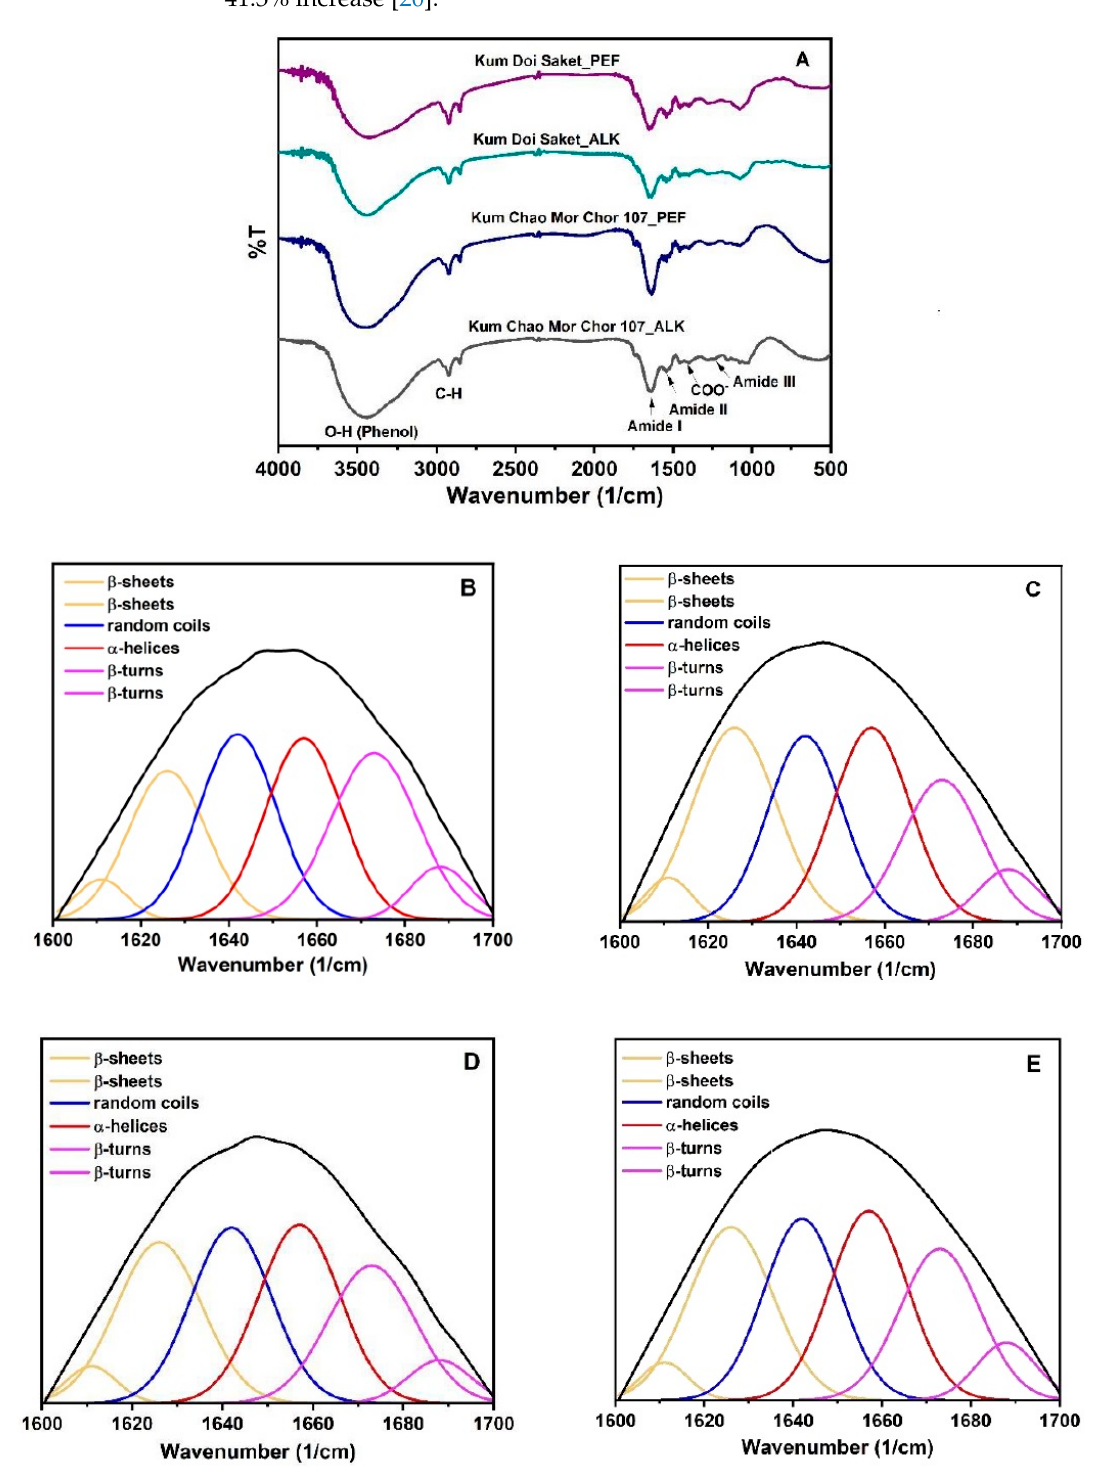
Figure 3. FTIR spectra ( A ) and peak-fitting of the secondary structure curves of “Kum Chao Mor Chor 107” protein from ALK ( B ) and PEF ( C ) treatments, and “Kum Doi Saket” Protein from ALK ( D ) and PEF ( E ) treatments.